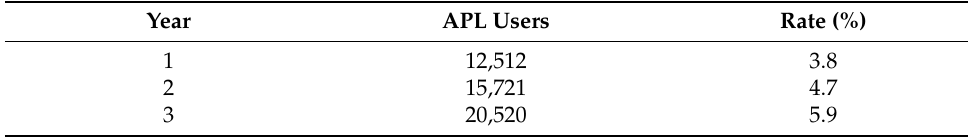
Figure 5. APL users evolution rate over 3 years. Table 6. APL users results for each year.